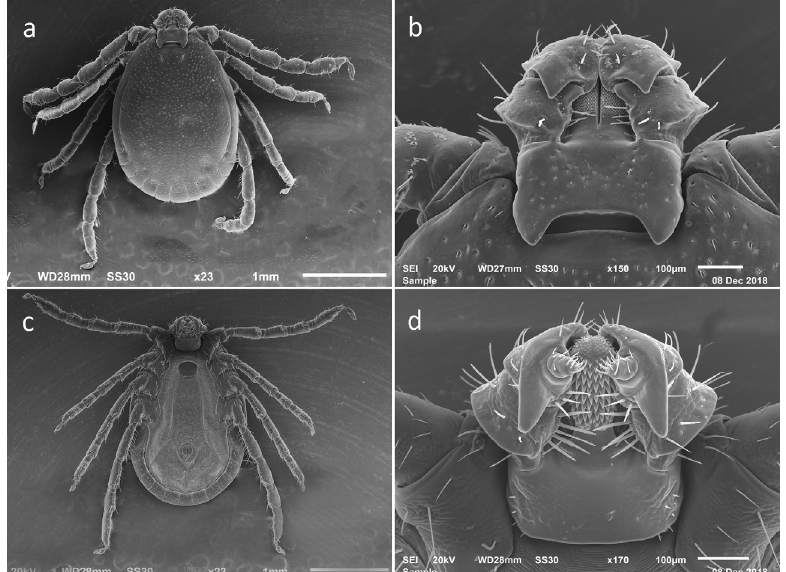
Figure 2. SEM photos of male H. longicornis from a colony started with specimens from Jeju-teukbye- oljachido, Republic of Korea. (Accession # RML48803) a dorsal full body b dorsal capitulum c ventral full body d ventral capitulum.